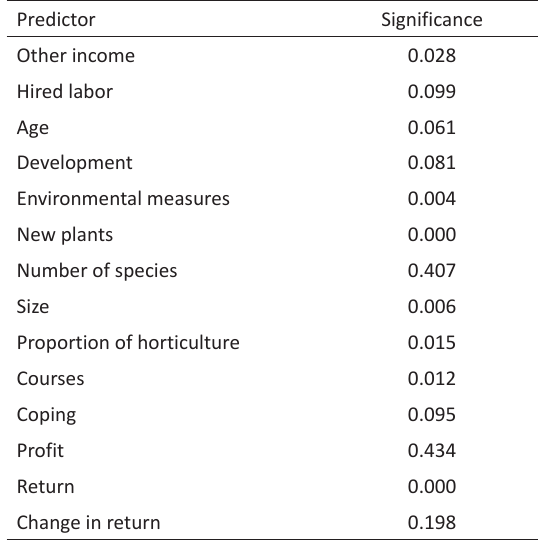
Table 3. Statistical significance of each predictor in logistic models including only one predictor